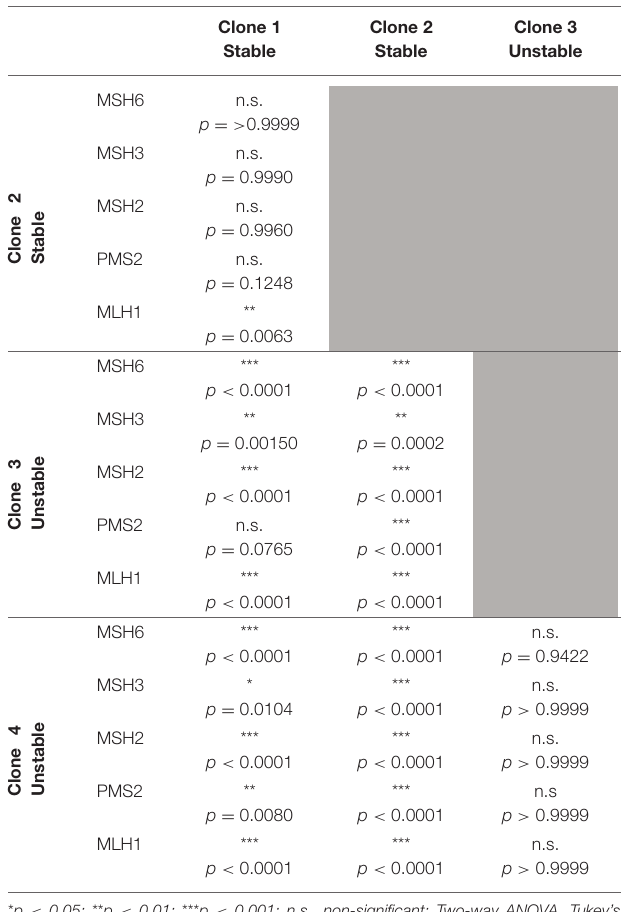
TABLE 2 | Statistical comparison of MSH6, MSH3, MSH2, PMS2 and MLH1 protein levels between clones.